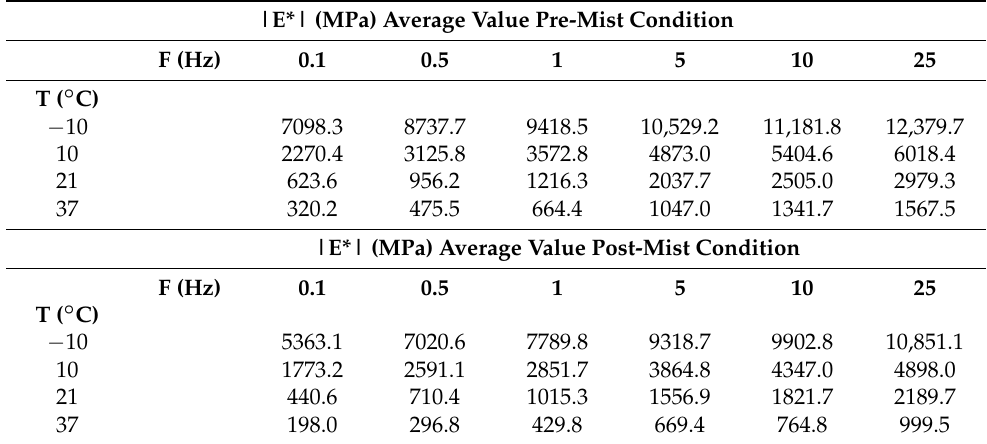
Table 2. Average dynamic modulus value pre-mist and post-mist condition.